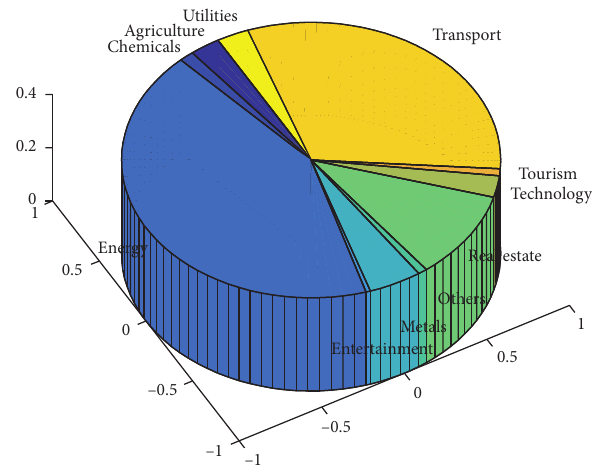
Figure 11: Overall sectional distribution (2005–2017) (No.